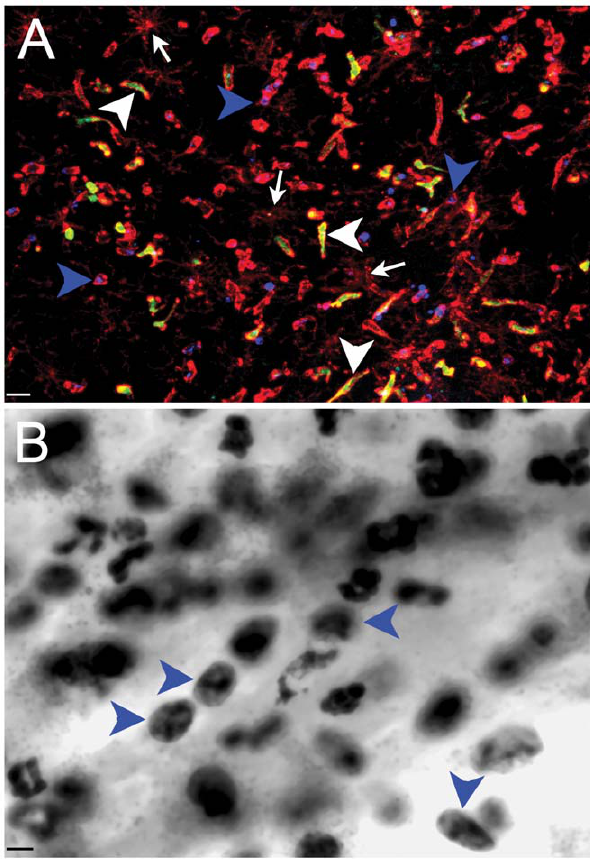
Figure 6. Stereotactic injection of Tat into hippocampus induces Infiltration of polymorphonuclear cells 24 hours later. Panel A illustrates combined immunofluorescence staining of CD11b (red), MPO (Blue), Iba-1 (white), and GFP (green) cells in a representative tissue section from a congenic CD45.1 host engrafted with homozygous CX3CR1/GFP + / + marrow that received Tat. Blue arrowheads point to CD11b + /MPO + /GFP 2 infiltrating leukocytes, white arrowheads point to CD11b + /MPO 2 /GFP + infiltrating leukocytes, and white arrows point to CD11b + low /MPO 2 /GFP 2 ramified microglia. Panel B illustrates a 100 6 oil-immersion image from H&E staining of an adjacent section from Panel A and blue arrowheads point to polymorphonuclear cells. Scale bar=16 and 8 m m for Panels A and B, respectively. n=3 independent replicates for Tat treatment.